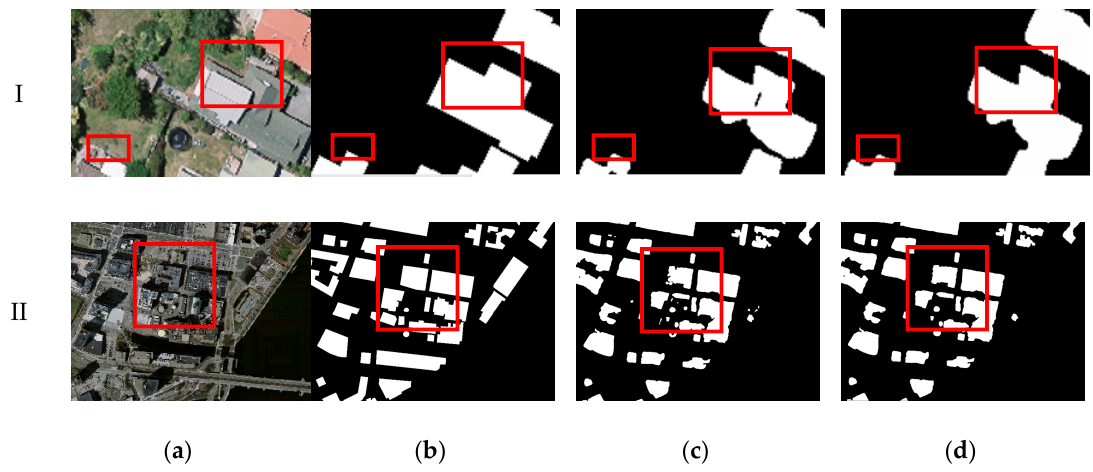
Figure 11. The detailed annotation of building extraction results, where I are from the WHU building dataset, and the II are from the Massachusetts building dataset. ( a ) Image; ( b ) Label; ( c ) D-Linknet; ( d ) MSCRF.